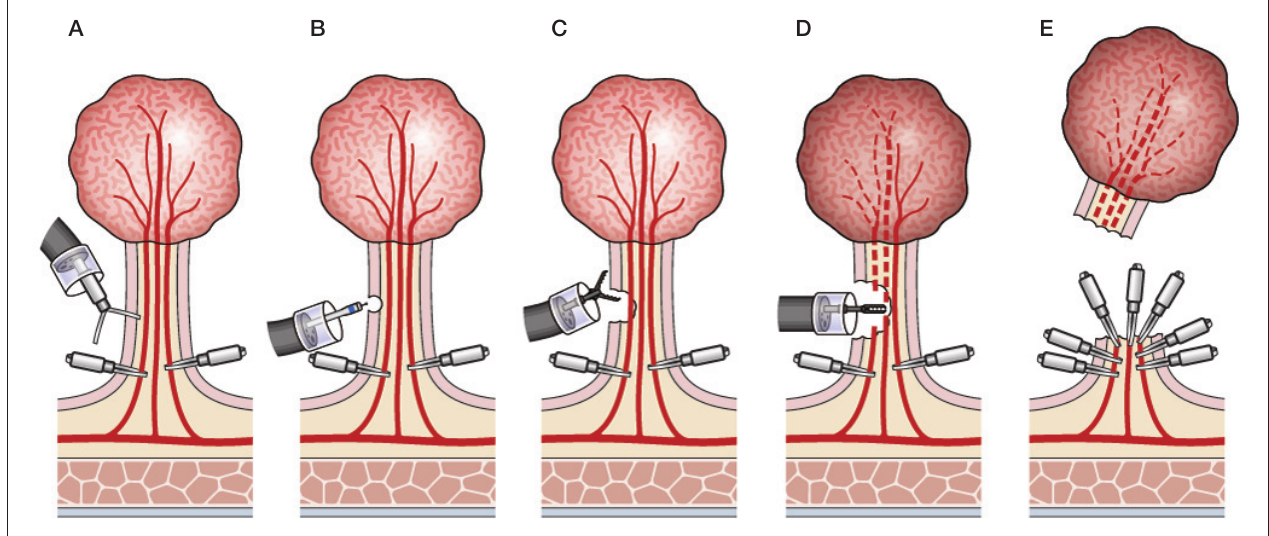
Figure 3) Schematic of endoscopic resection for a giant pedunculated polyp with grasping-type scissor forceps. A Applying propylactic clips at the both sides of the stalk is ineffective in occluding the blood supply. B After injection of hyaluronic acid solution, which includes epinephrine and indigo carmine dye, to the stalk, a dual electrosurgical knife cuts mucosa of the stalk. C Grasping-type scissors forceps are then used to proceed with the resection. D Hemostasis is performed simultaneously, and bleeding is now controlled. E For better hemostasis, additional endoclips are applied around the